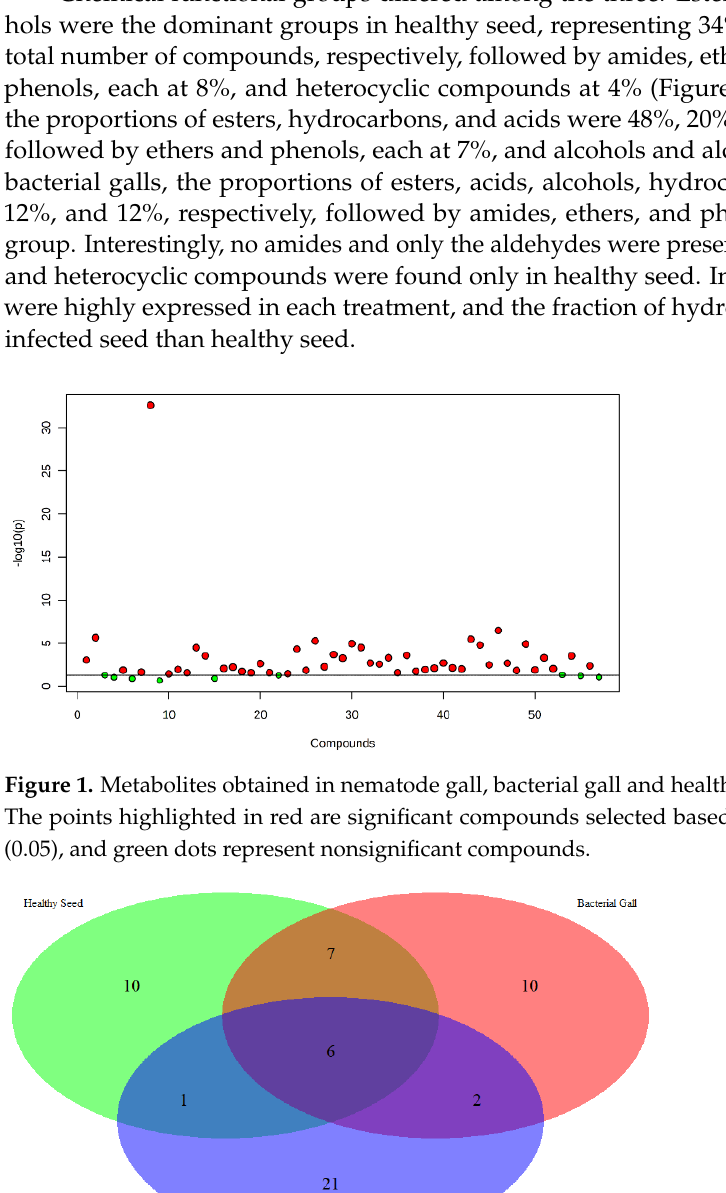
Figure 2. Venn diagram of the number of metabolites expressed in nematode gall ( Anguina funesta ), bacterial gall ( Rathayibacter toxicus ), and healthy seed of ryegrass ( Lolium rigidum ).